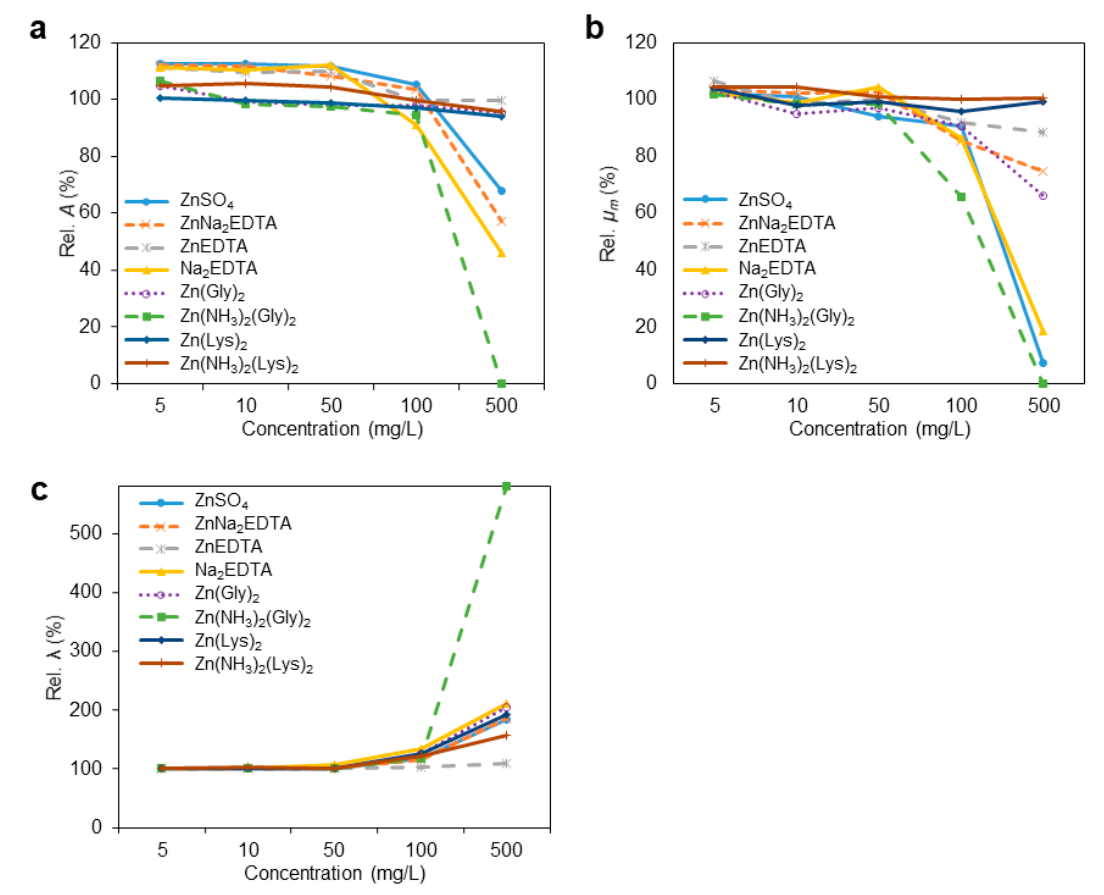
Figure 5. Effect of increasing doses of test compounds on the growth parameters of S. cerevisiae , ( a ) relative maximal growth (Rel. A ), ( b ) relative growth rate (Rel. μ m ), and ( c ) relative lag phase (Rel. λ ). The growth parameters are shown relative to the test-compound-free S. cerevisiae growth